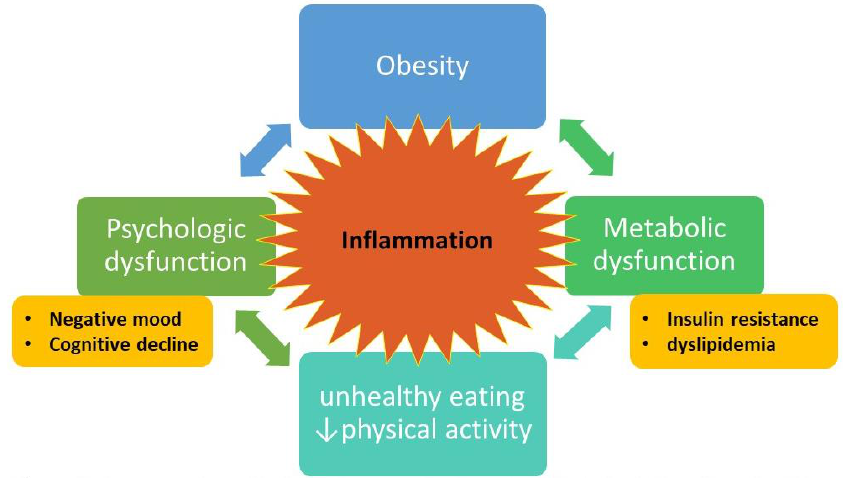
Figure 1. Conceptual model of obesity = metabolic and psychological dysfunction = inability to effect behavioral change to reverse obesity. Bidirectional arrows indicate feedback loops that form the intractable cycle. Inflammation is central to the model, with cytokines and other inflammatory factors fueling the bidirectional connections. Figure designed by L.D.Y. and S.D.